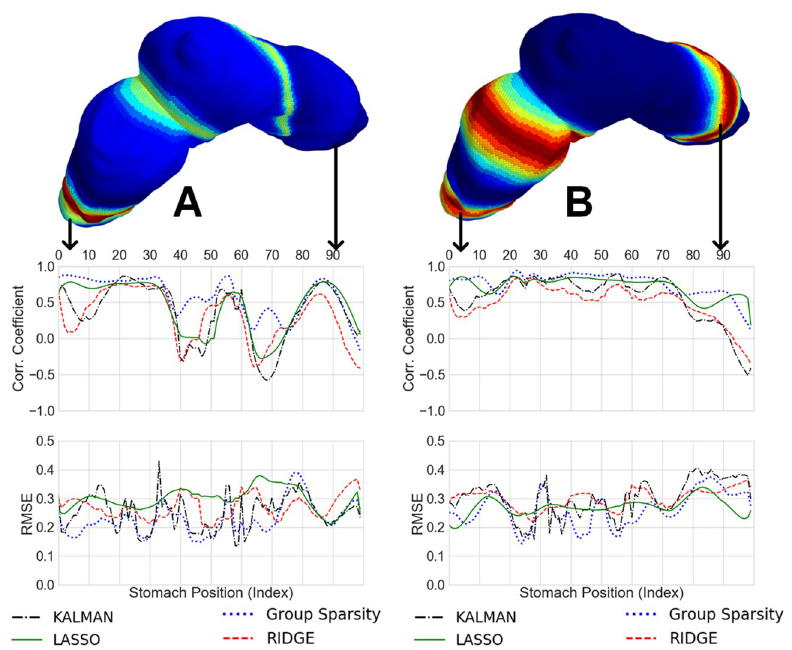
Fig 7. Average correlation coefficient and RMSE for the 10 dB noise level across geometry (All methods). A) Normal simulation inverse results average correlation coefficient and RMSE as a function of geometry, B) Abnormal simulation inverse results average correlation coefficient and RMSE as a function of geometry.